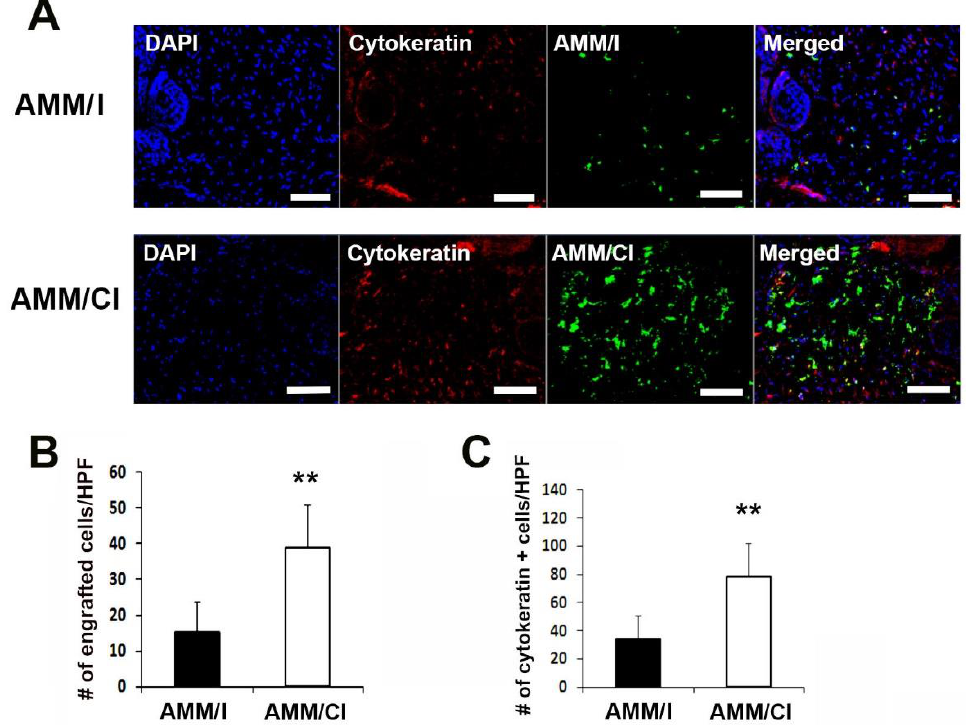
Figure 6. AMM/CI showed high engraftment and epithelization potentials in wound tissue. ( A ) Representative images of cytokeratin immunostained wound tissue sections 10 days after cell injection. Bars = 200 µ m. ( B ) Quantification of engrafted cells in the wound area after cell injection. ** p < 0.01, n = 7 per group. Engrafted AMM/CI were measured in the skin wound at 10 days after cell transplantation. ( C ) Quantification of cytokeratin‑expressing cells in skin wound tissues. Cytokeratin‑positive cells were measured in the skin wound tissues at 10 days after cell transplantation. ** p < 0.01, n = 6 per group.